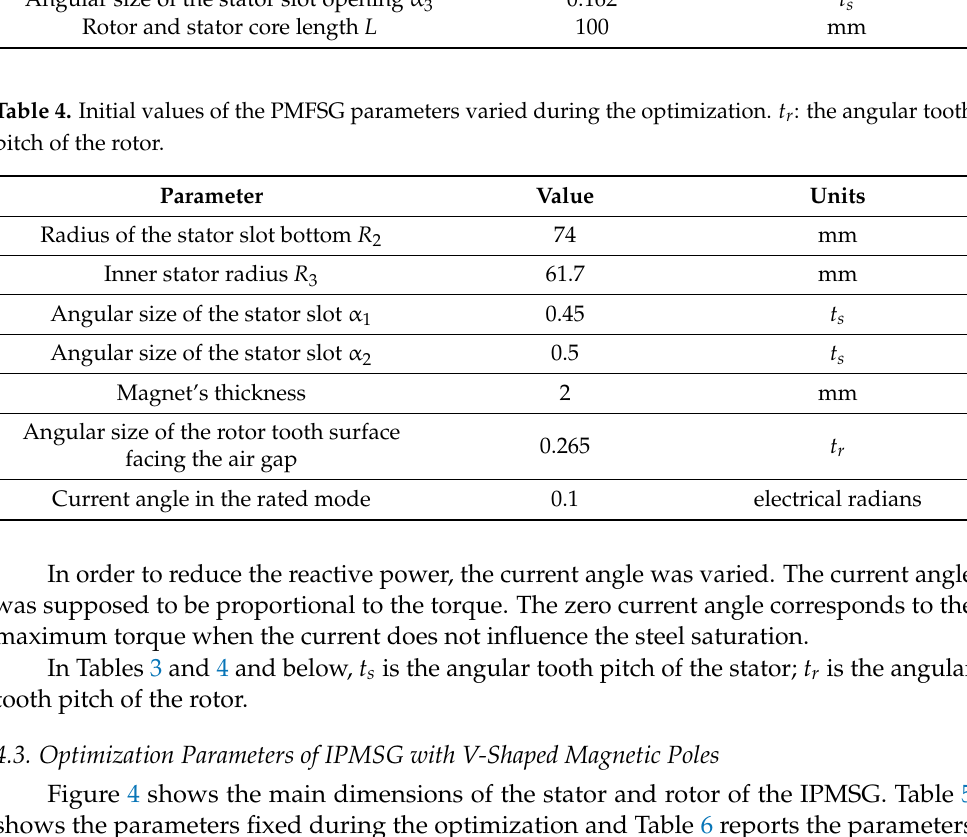
Table 4. Initial values of the PMFSG parameters varied during the optimization. t r : the angular tooth pitch of the rotor. Parameter Value Units